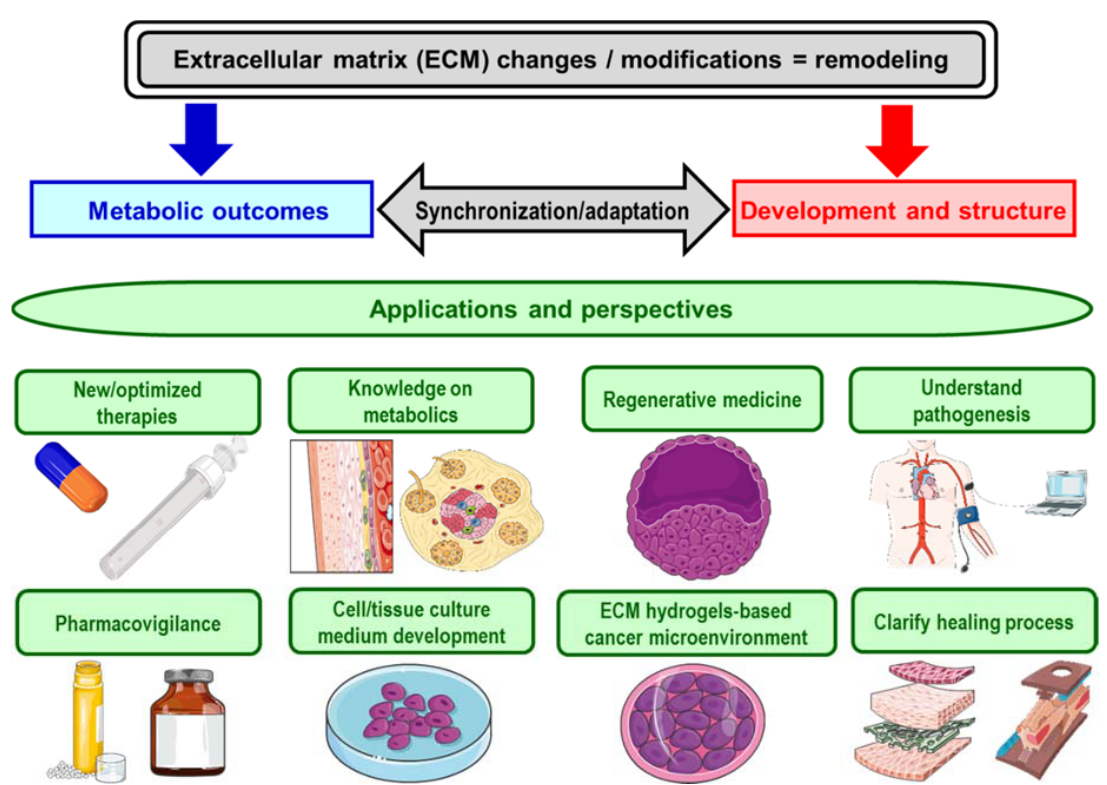
Figure 3. Metabolic–structural synchronization of the extracellular matrix properties.